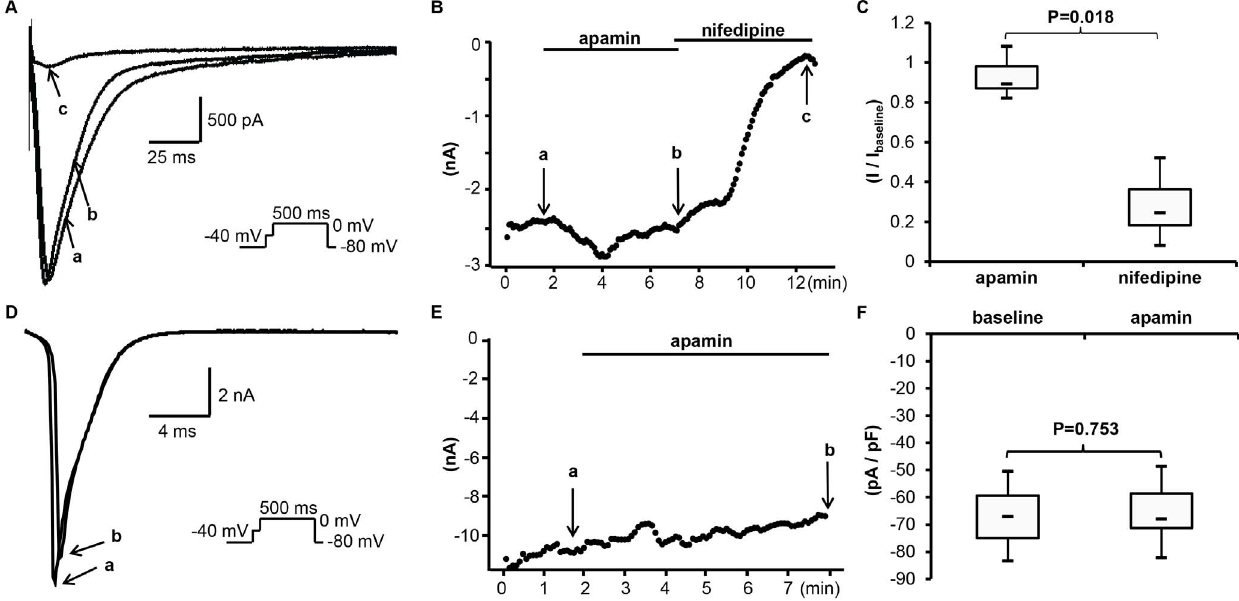
Figure 7. Effects of apamin on I Ca and I Na in rabbit cardiomyocytes. (A) The representative I Ca tracings obtained by a pulse protocol shown in the inset before apamin (a), after apamin (b) and after nifedipine (c) at time points indicated by arrows a through c, respectively, in (B). (B) The time course of peak I Ca measured at 0 mV. (C) The summary of drug effects normalized to baseline. (D) The representative tracings of I Na obtained by a pulse protocol shown in the inset before apamin (a), after apamin (b) at time points indicated by arrows a and b, respectively, in (E). (E) The time course of peak I Na at –40 mV. (F) The summary of current densities before and after apamin.